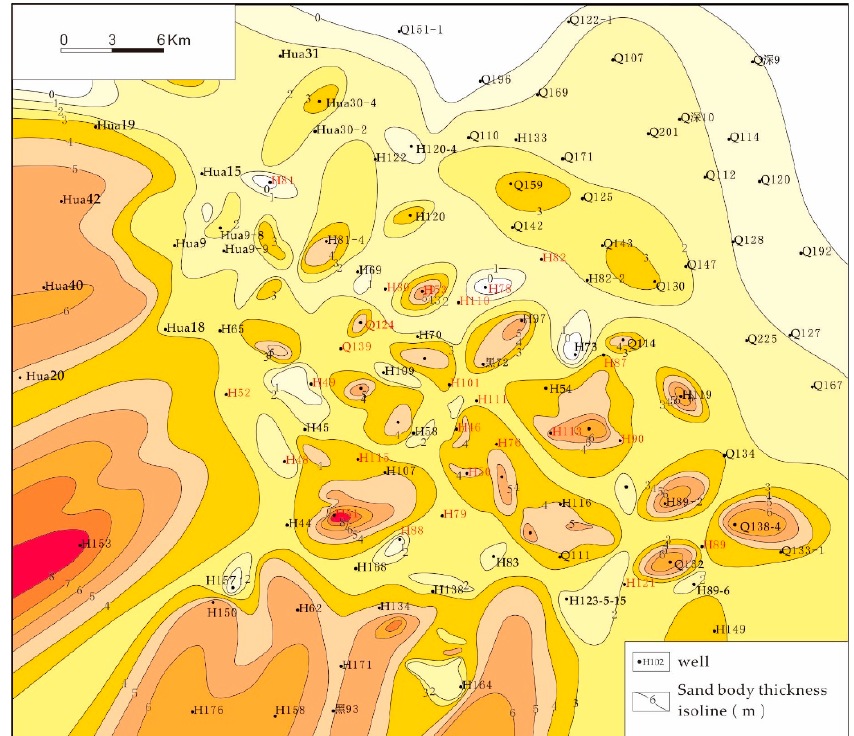
Figure 3. Distribution characteristics of the isolated bodies in Thin Layer 1 of Sand Bed I in q n2 member of Daqingzijing Oilfield. (The figure uses data from 1000 wells, and the producing wells are not be shown).